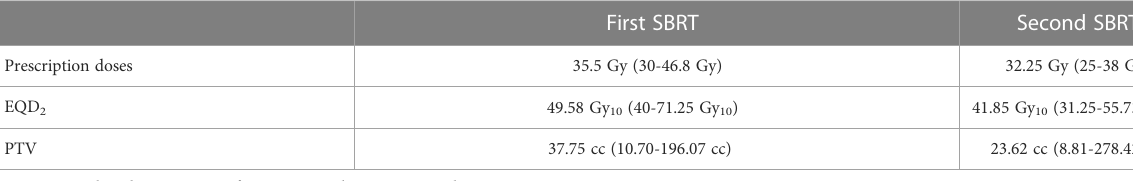
TABLE 2 Prescription doses to the PTV.